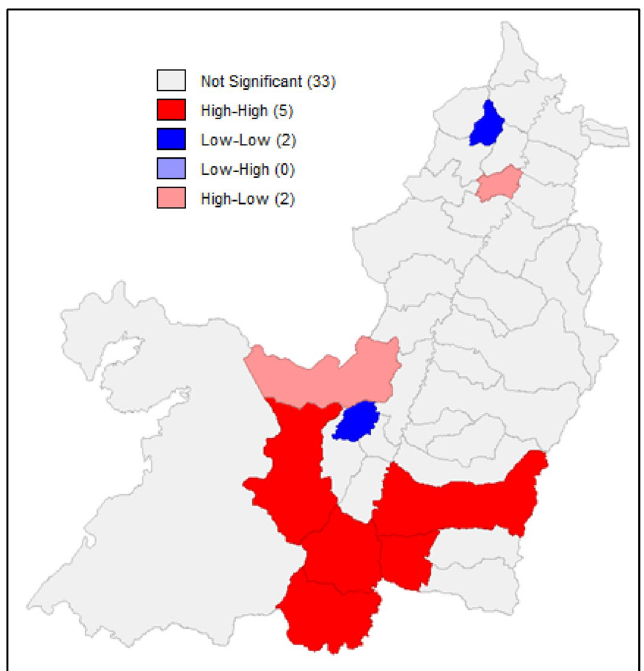
Fig. 5 Bivariate Moran Index between the 2010 fiscal efficiency and the population density. Source: own computation based upon GeoDa